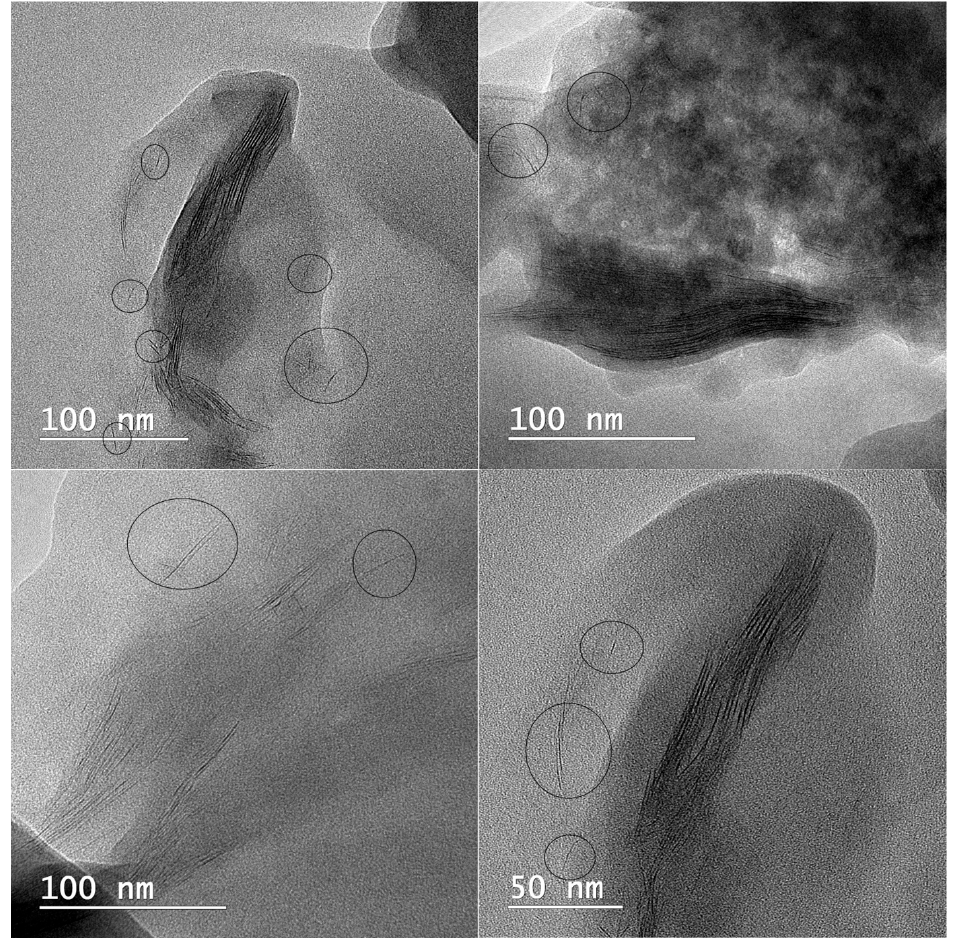
Figure 8. TEM micrographs showing the intercalated/exfoliated state of Cl 93A-C18 clay layers within PMAA matrix; exfoliated state is in minority and is highlighted with encirclement.